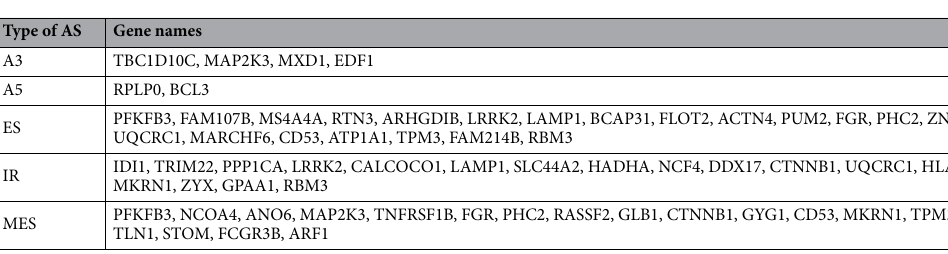
Table 4. Common genes with significant alternative splicing events identified by both rMATS and DEXseq. AS alternative splicing, ES exon splicing, IR intron retention, MES mutually exclusive splicing.